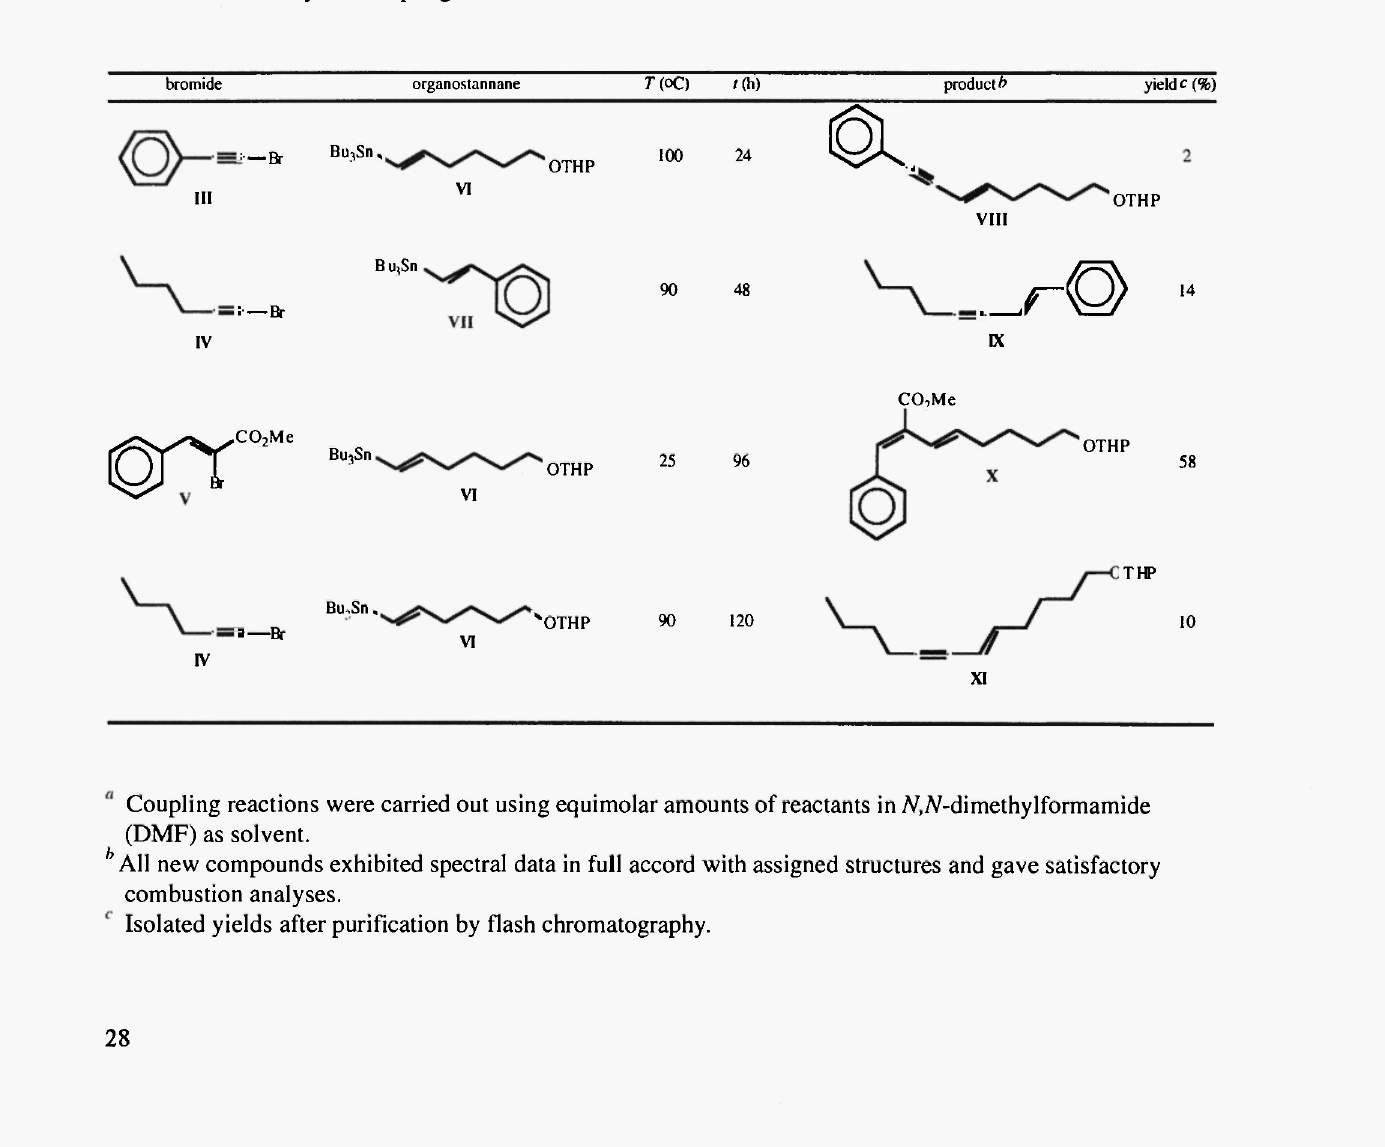
Table I. Non-catalyzed Coupling Reactions"